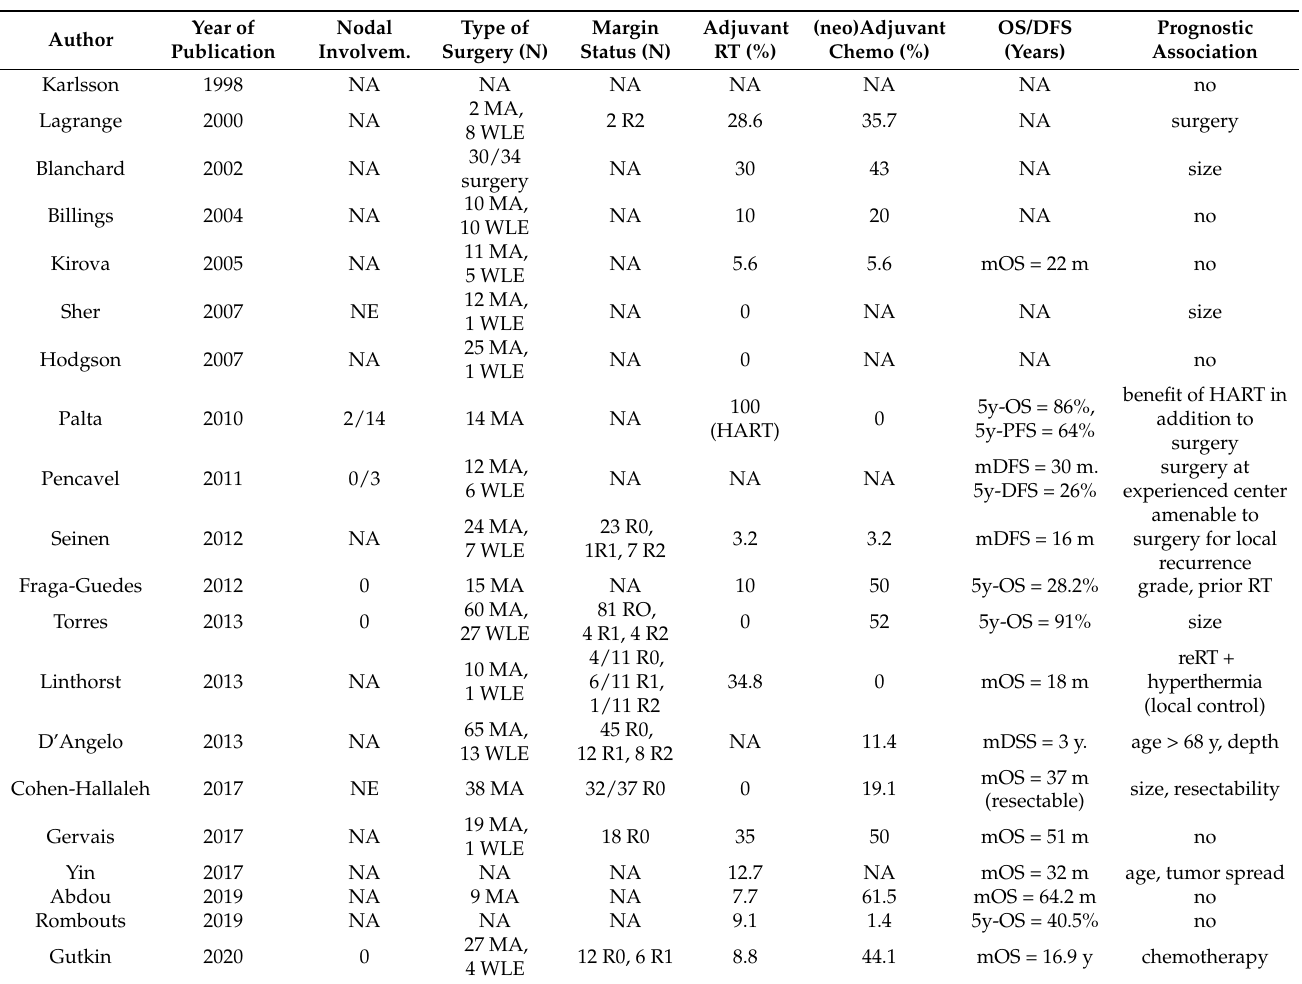
Table 3. Treatment modalities and prognosis of radiation-induced breast sarcoma in retrospective studies including ≥ 10 cases (excluding bone sarcomas). NA: Not